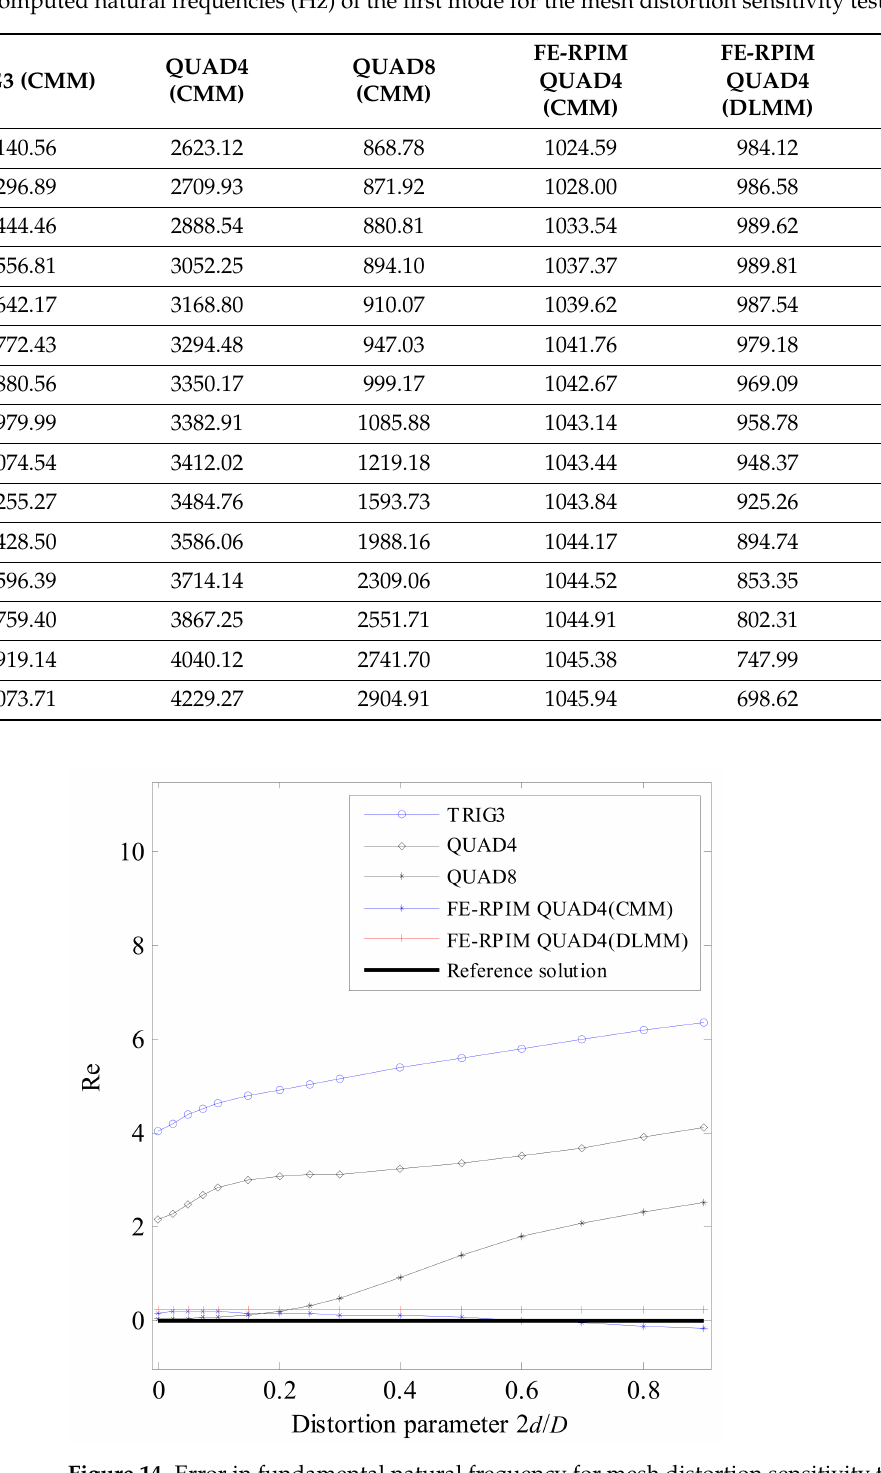
Figure 14. Error in fundamental natural frequency for mesh distortion sensitivity